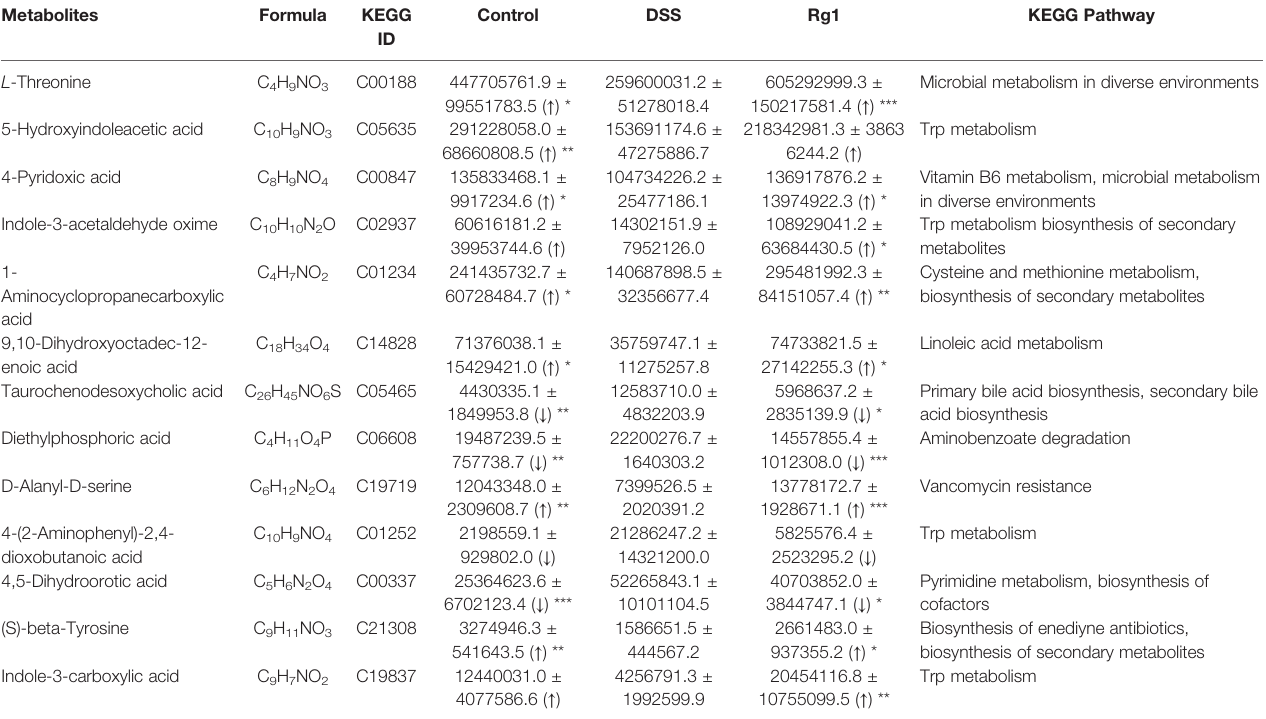
TABLE 1 | The differential metabolites with the dose-effect relationship among three